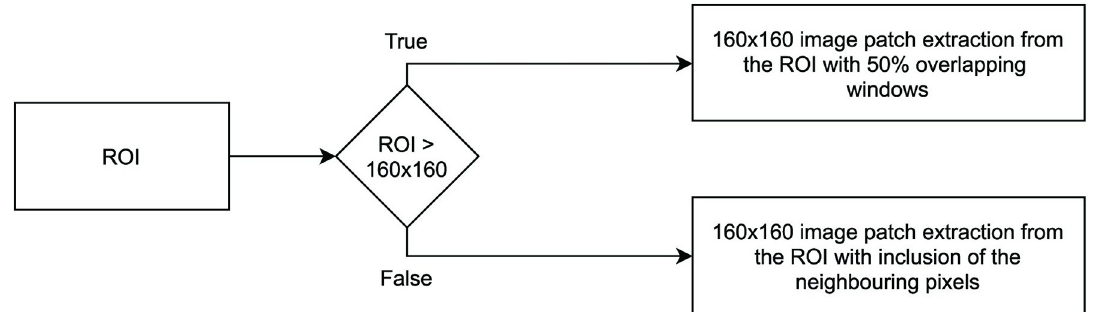
Fig 11. Image patches conversion